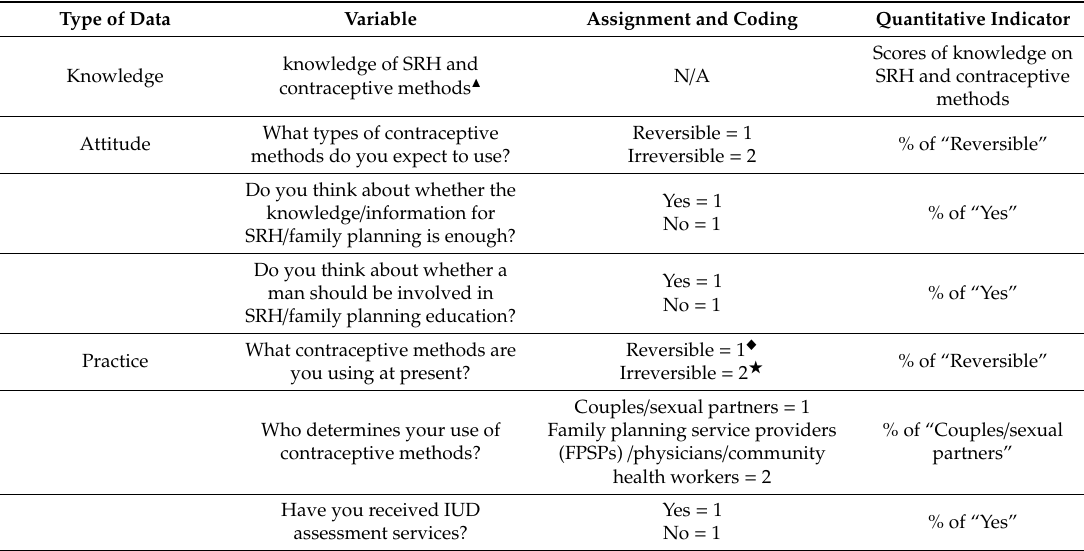
Table A1. Quantitative data for the intervention evaluation of the two cities, Jun